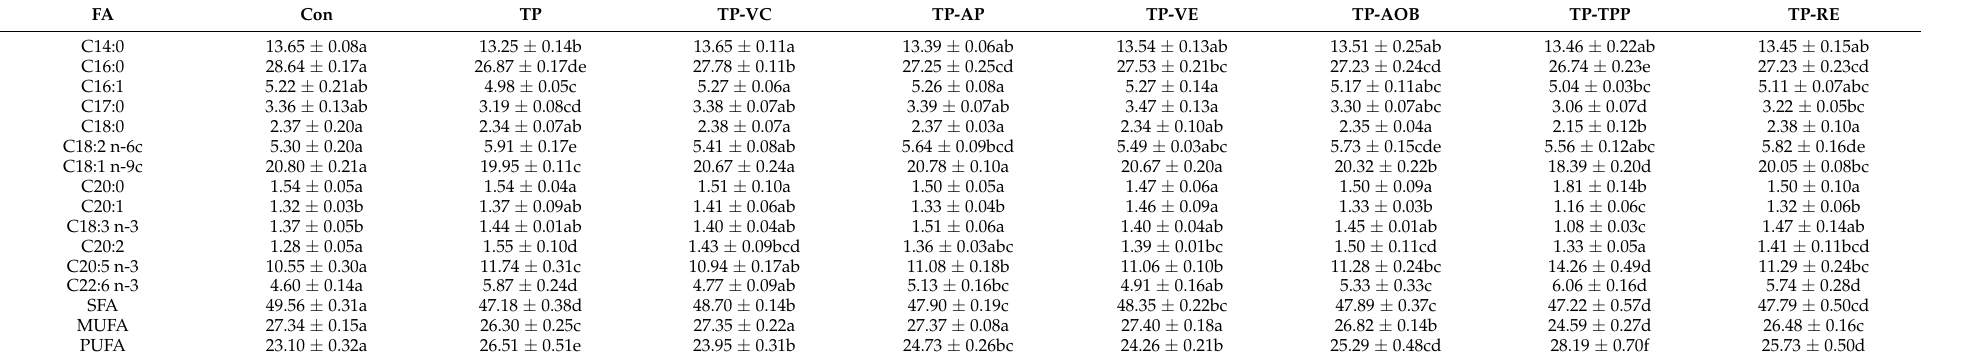
Table 2. The FA composition (relative content, %) of krill oils added with different composite antioxidants during the extraction